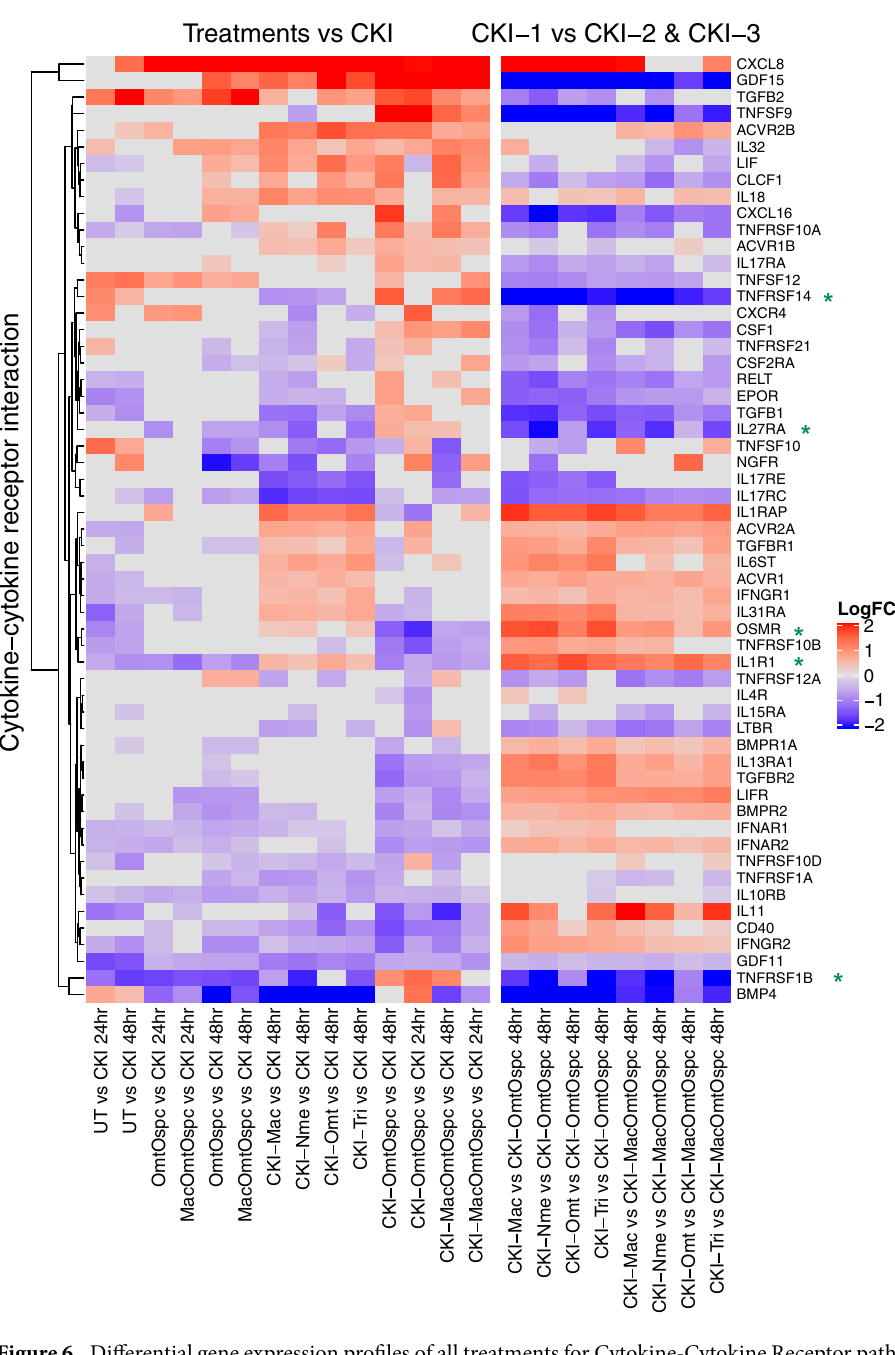
Figure 6. Differential gene expression profiles of all treatments for Cytokine-Cytokine Receptor pathway. The left panel shows comparison of subtractive fraction treated cells against CKI treatment and the right panel shows comparison of single compound subtractive fraction treated cells against the treatments for two and three compound subtractive fractions. Asterisks in green show a subset of genes that had opposite changes in gene expression across